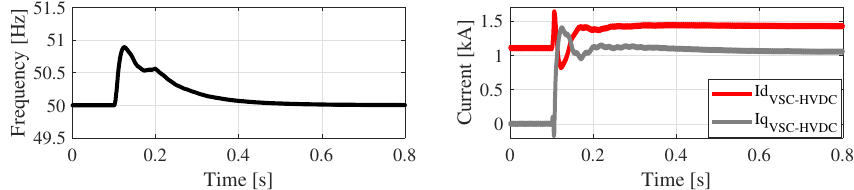
Figure 7. Offshore frequency ( left ) and currents ( right ) of VSC2 in the dq synchronous frame.